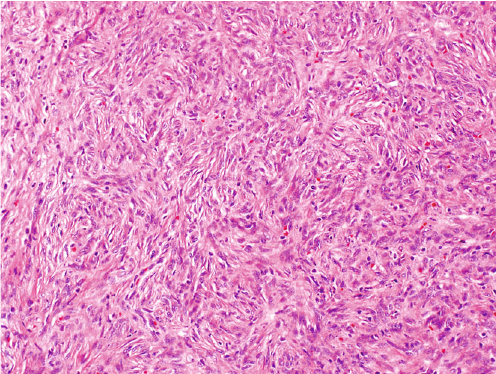
Figure 3: The tumor with spindle-shaped cells without a de fi ned architectural pattern forming short fascicles with interspersed thin collagen bundles (H&E, × 20).